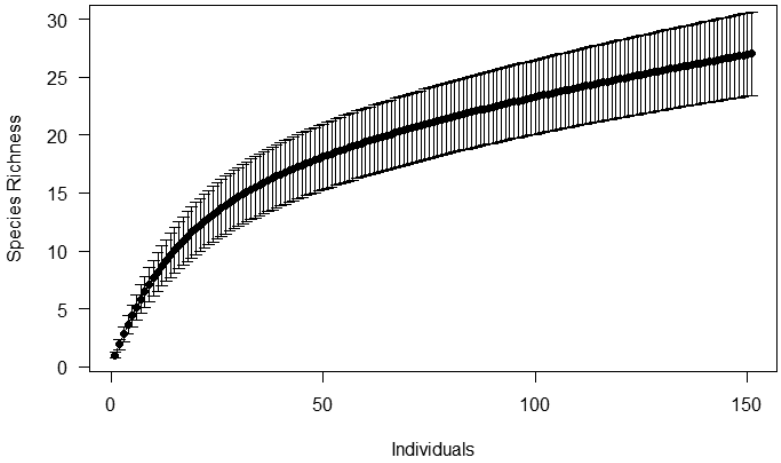
Figure 6. Individual-based rarefaction curve with standard deviation of snake species of south coast of